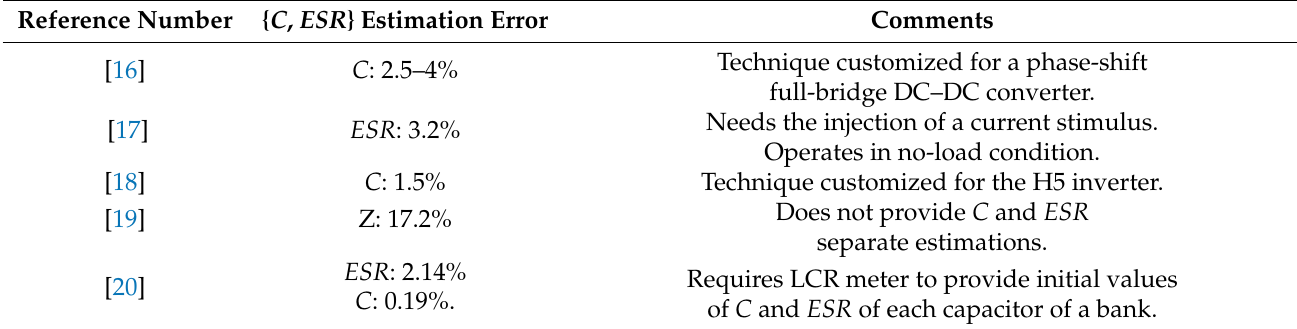
Table 1. Features of the methods proposed in